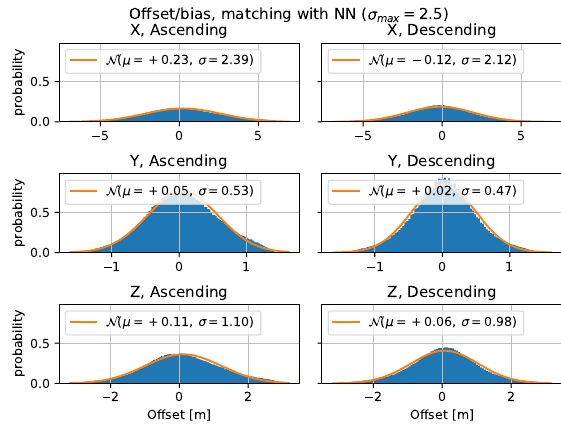
Figure 8. Offsets (biases) in matching, based on the first Nearest